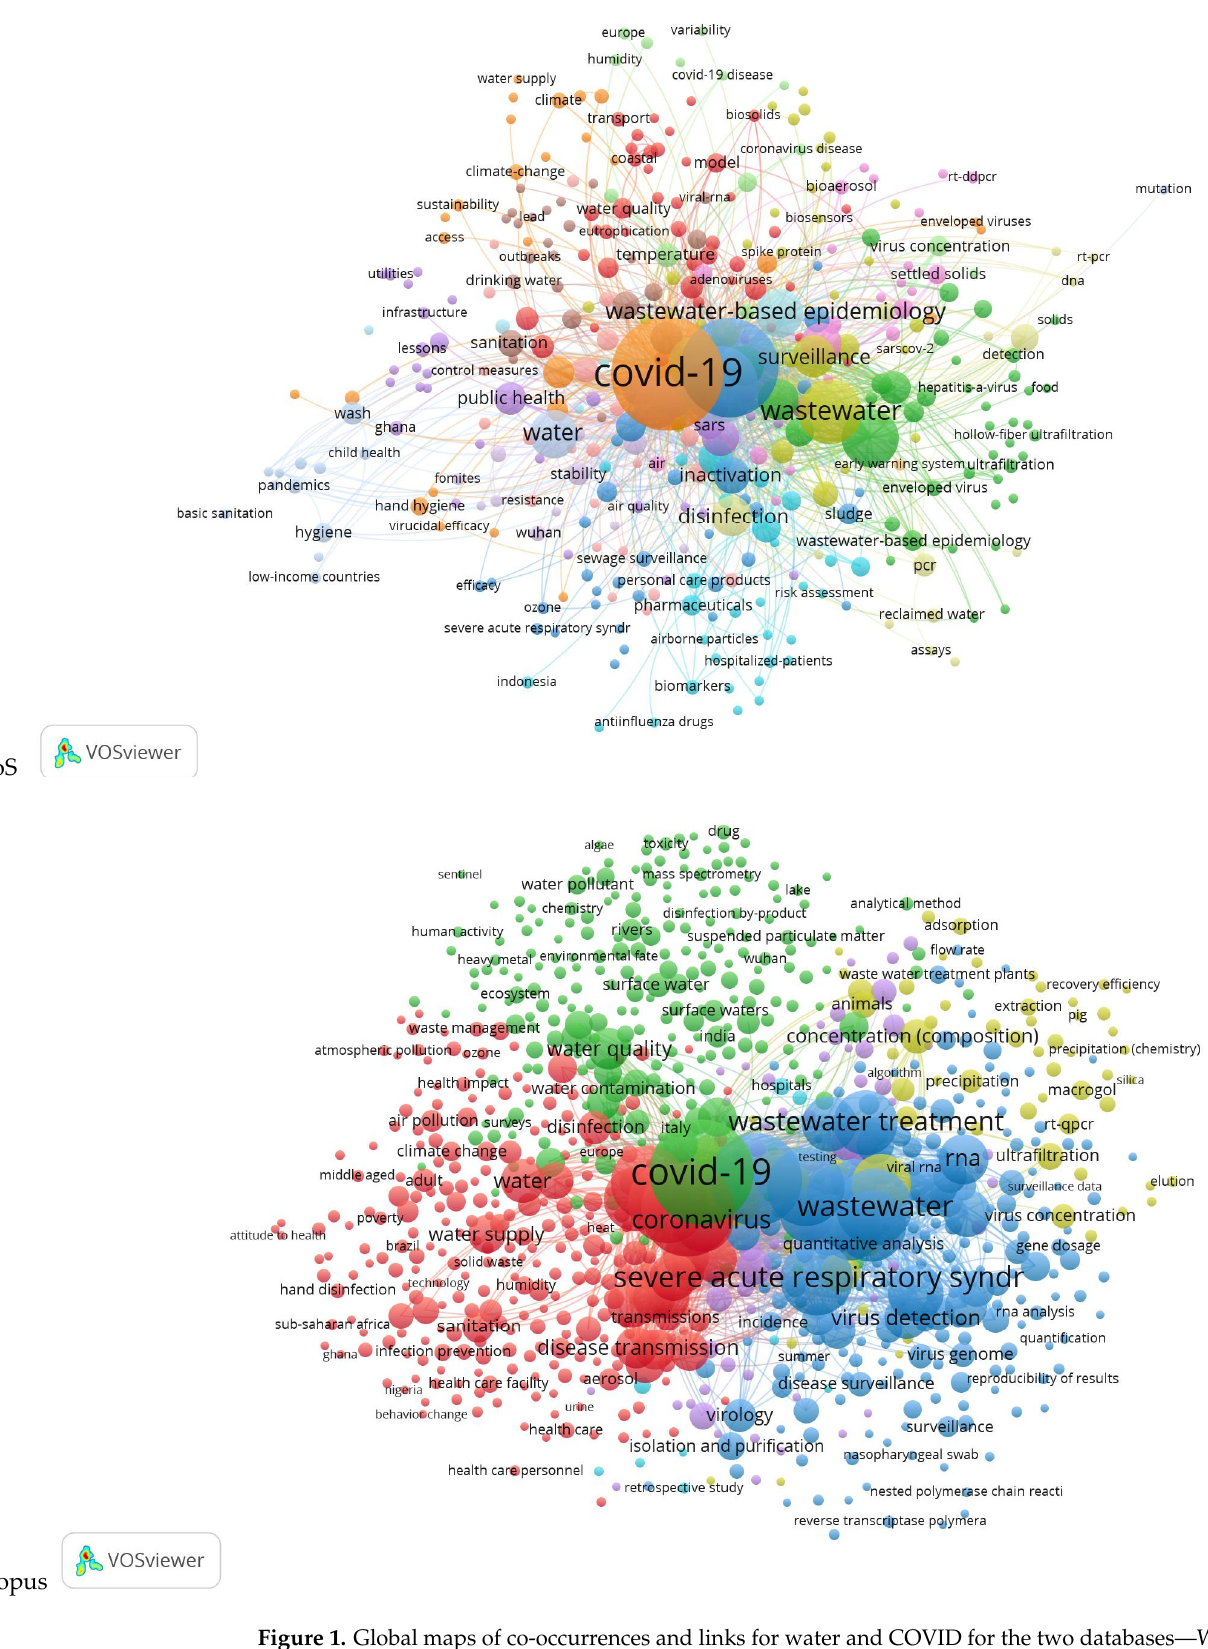
Figure 1. Global maps of co-occurrences and links for water and COVID for the two databases—WoS and Scopus.